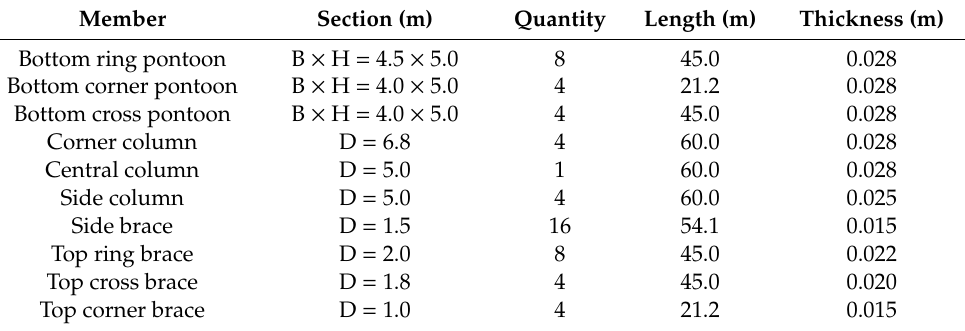
Table 1. Parameters for fishing cage structural members.